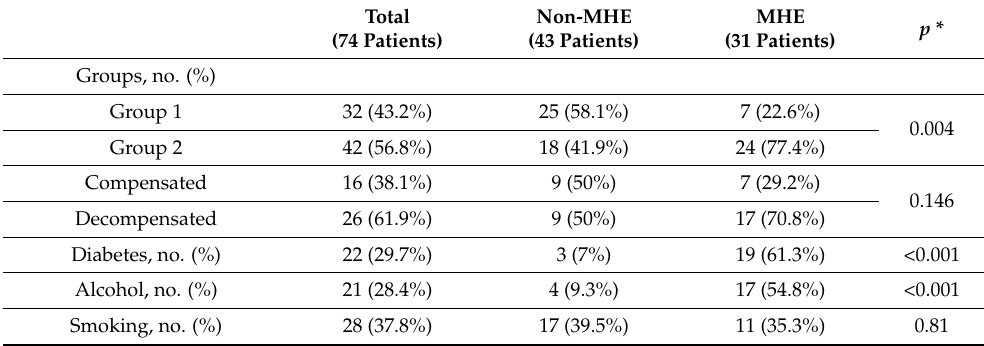
Table 4. Clinical data of patients with MHE in comparison with those without MHE.